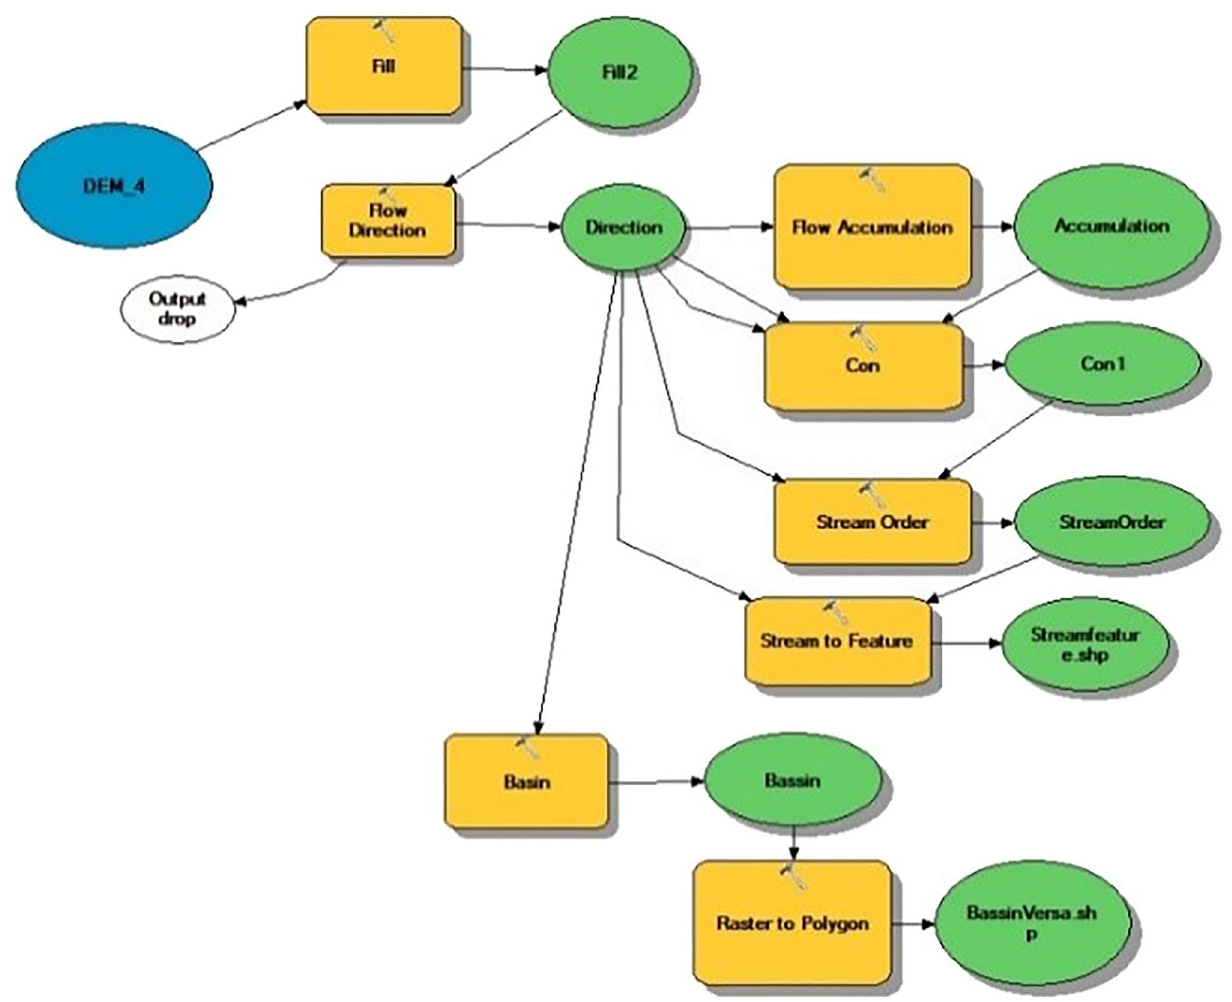
Fig. 11 Stream network delineation modelbuilder